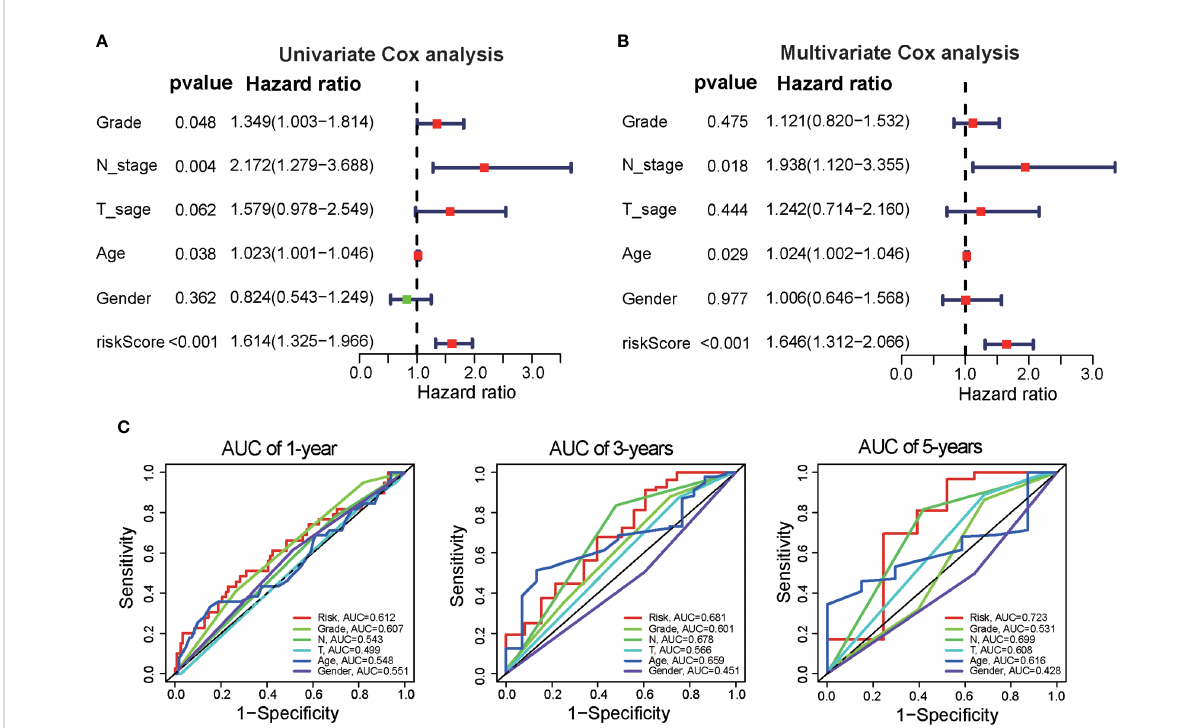
FIGURE 3 Independence of the DRG signature for survival prediction. (A) Univariate Cox regression analysis was performed to validate the prognostic values of clinical factors and risk scores in the TCGA dataset. (B) Multivariate Cox regression analysis was performed to verify the prognostic values of clinical factors and risk scores. (C) Time-dependent ROC analysis of the performance of the DRG signature in predicting clinical factors at 1 year, 3 years, and 5